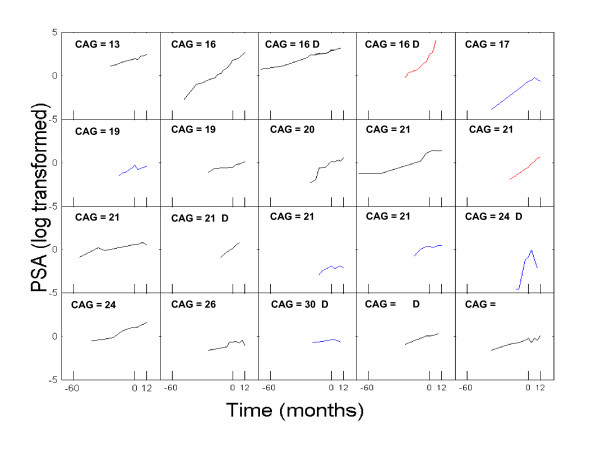
PSA levels in logarithm scale for each patient. Blue line (N = 6) represents the slope of PSA during isoflavone therapy was significantly lower than that before the therapy, red line (N = 2) represents the slope of PSA during isoflavone therapy was significantly higher than that before the therapy and black line (N = 12) represents the slope of PSA during isoflavone therapy was unchanged than that before the therapy. CAG, CAG androgen receptor polymorphisms. D, subject who dropped out before completion of the therapy.